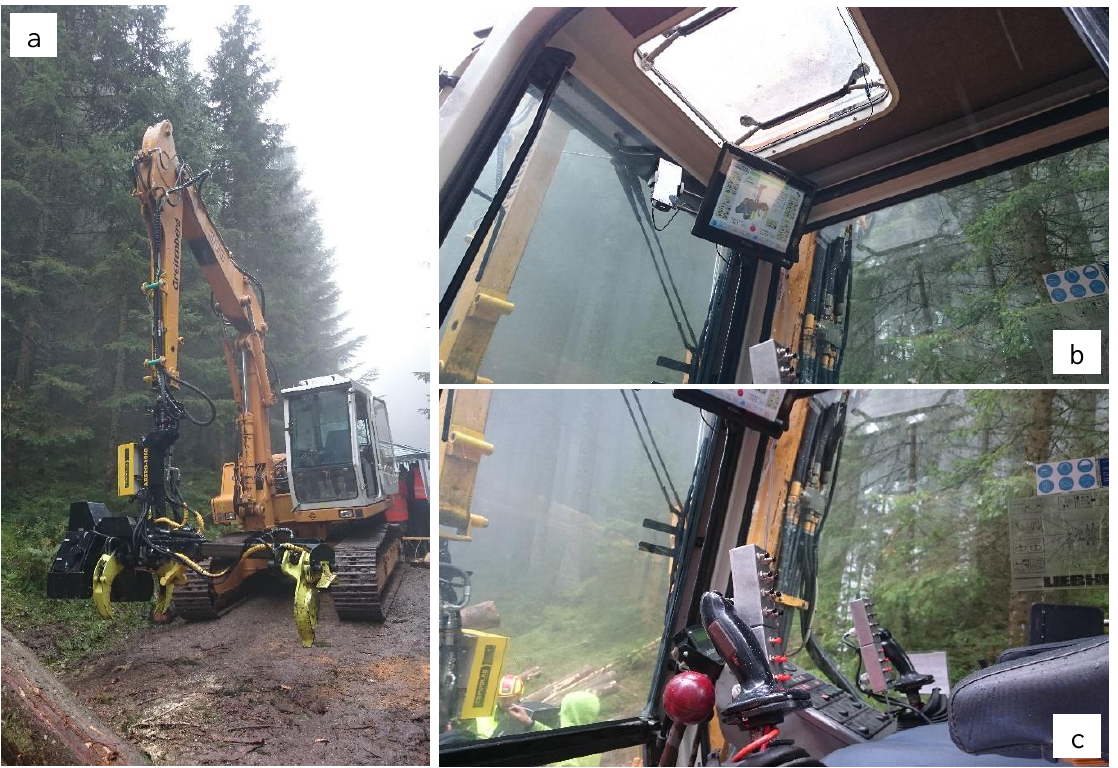
Figure 5. (a) Intelligent processor head on the Liebherr excavator. (b) System status display mounted at the top of the cab. (c) Processor head control units beside the joy sticks.